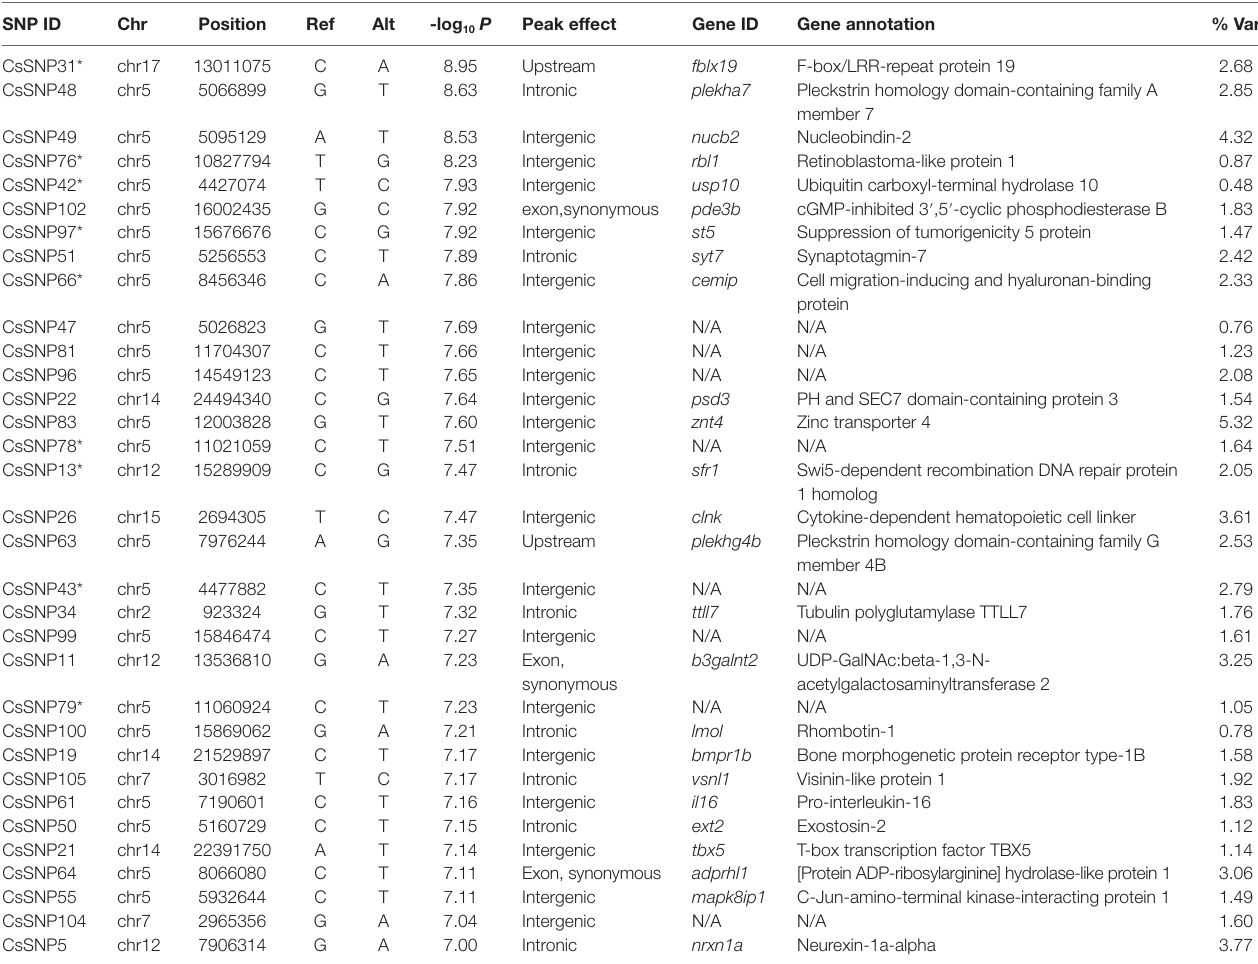
TABlE 2 | The single-nucleotide polymorphisms (SNPs) significantly associated with the disease